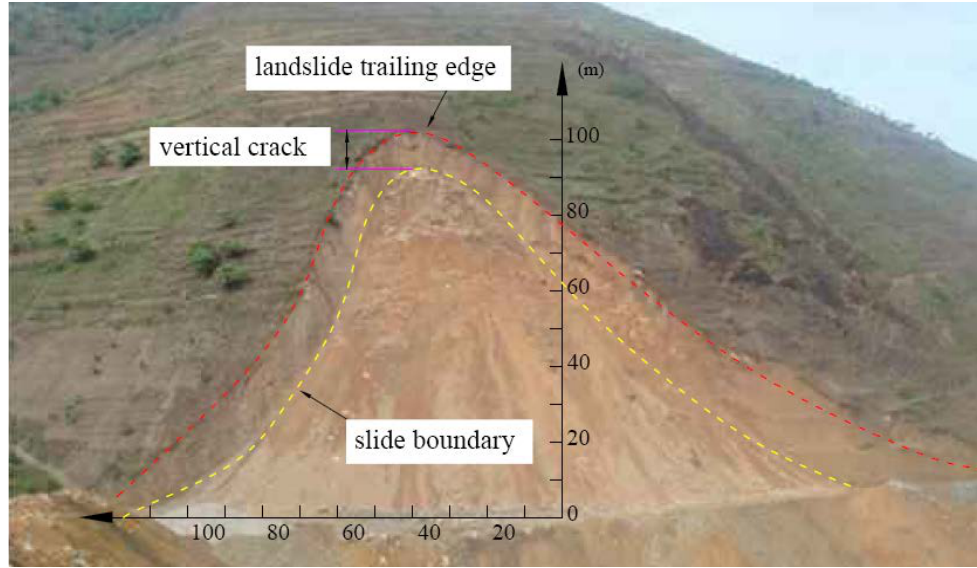
Figure 15. Morphology of highway landslide after collapse in Yunnan Province.